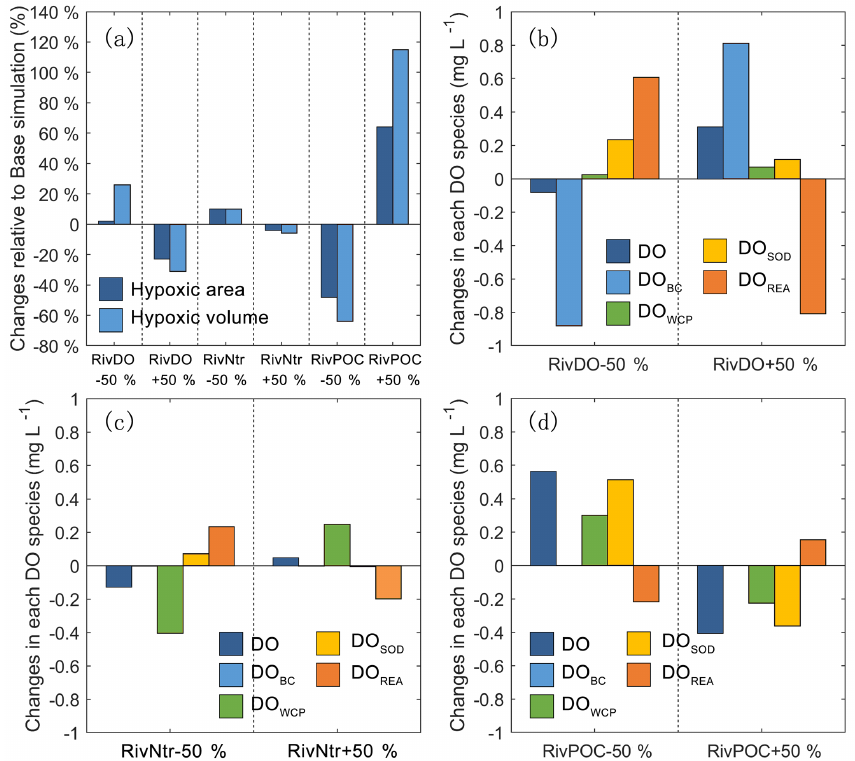
Figure 7. The percentage changes in the hypoxic area and hypoxic volume in each simulation relative to the Base simulation (a) . The changes in each DO species averaged over the high-hypoxic-frequency zone (denoted as the white contour in Fig. 6) in DO simulations (b) , nutrient simulations (c) , and POC simulations (d) relative to the Base